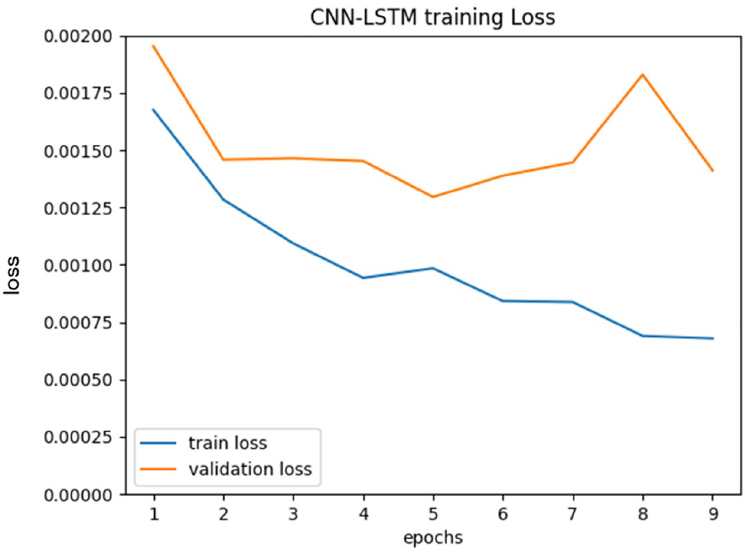
Fig 6. Loss curve of our factory-segmentation-pre-trained CNN-LSTM training.